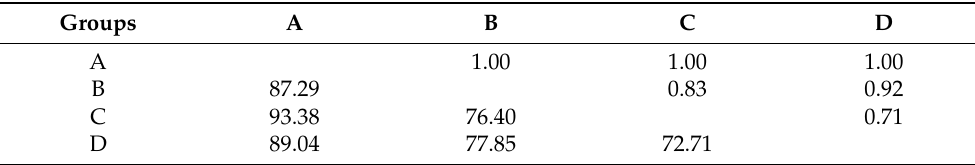
Table 2. ANOSIM and SIMPER analysis between groups.